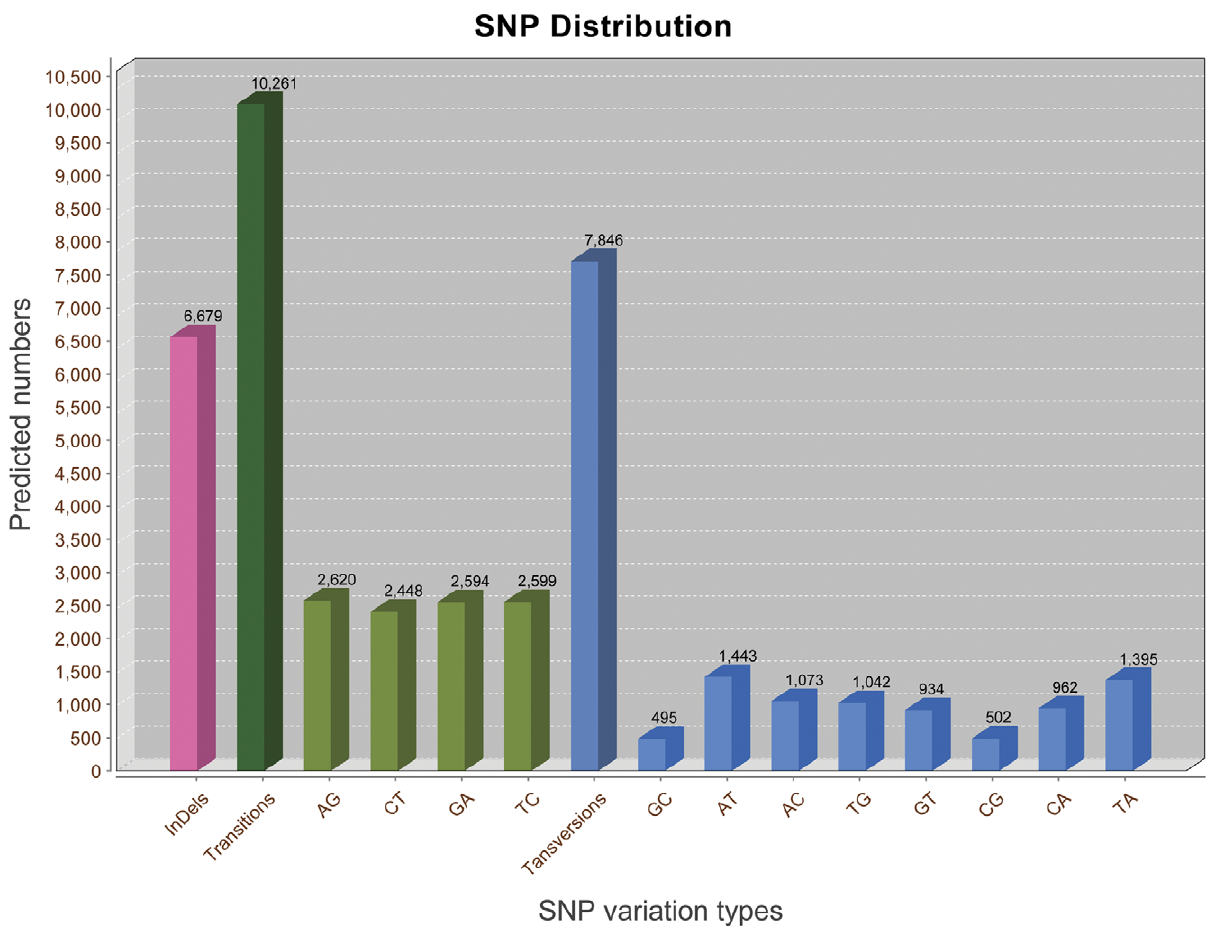
Figure 5. Distribution of putative single nucleotide polymorphisms ( SNP ) in the transcriptome of M.nipponense .